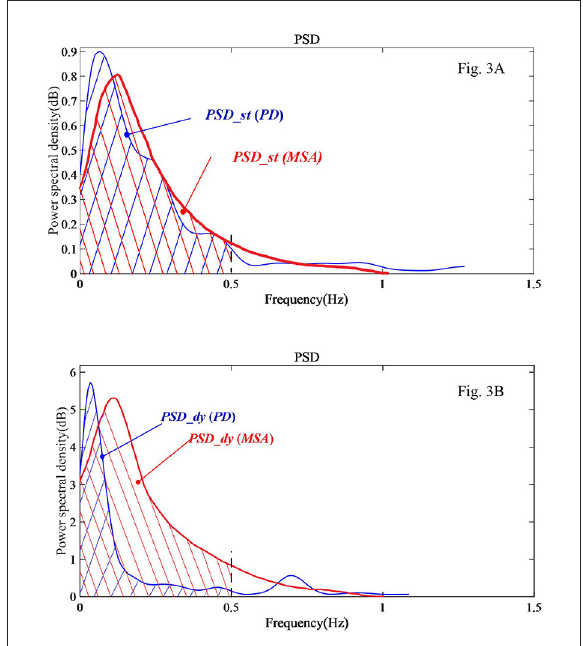
FIGURE3 PSD analysis diagram of a sample PD and a sample MSA patients’ COP signal in the EO state. (A) Static balance experiment. (B) Dynamic balance experiment.